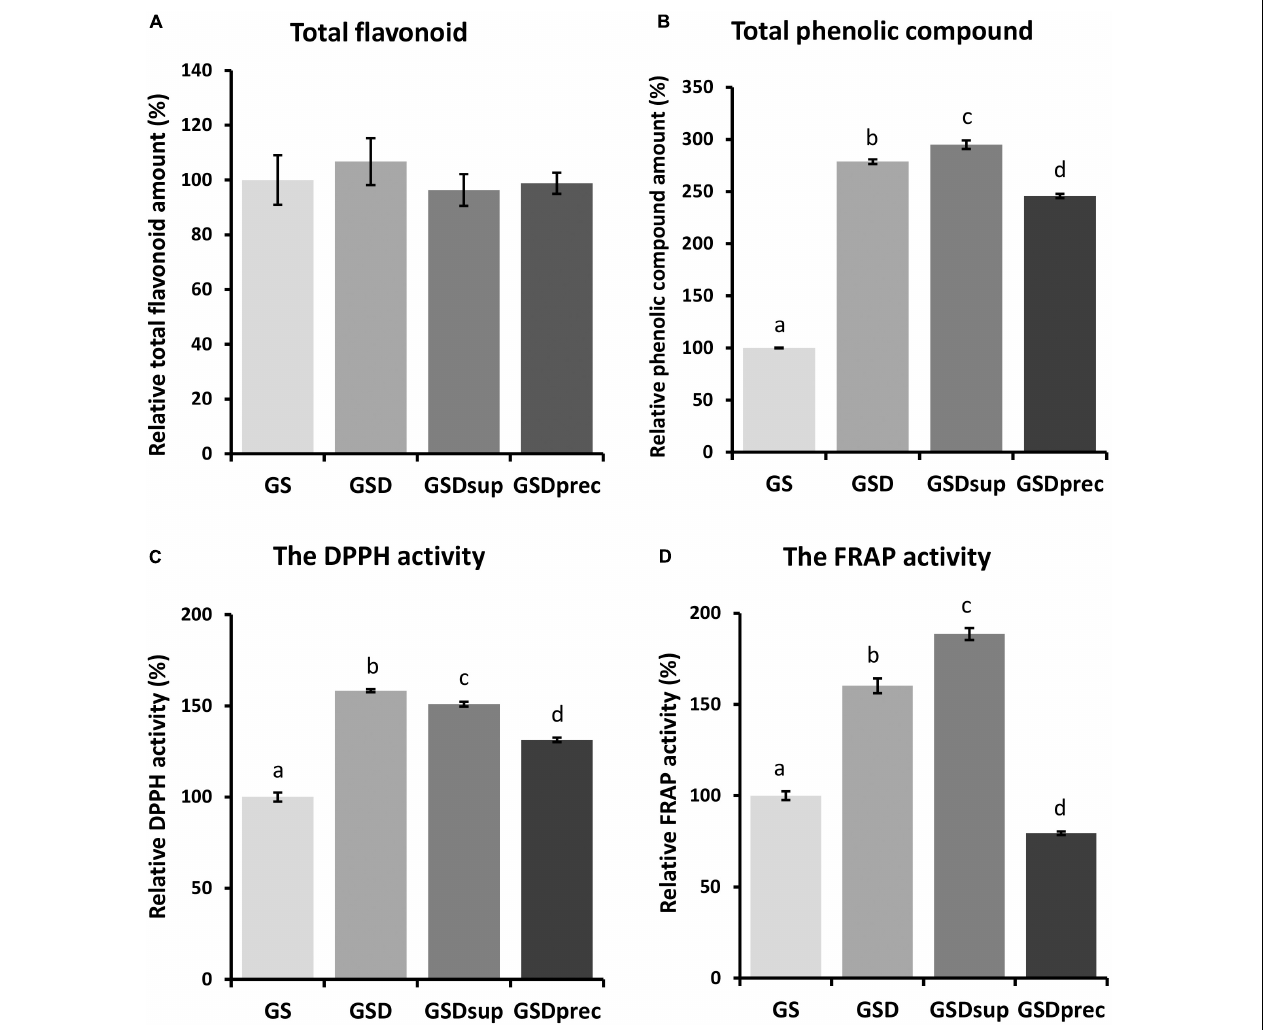
FIGURE 4 | The amounts of phytochemicals and antioxidant activities of 80% methyl alcohol (MeOH) extracts of GS, GSD, GSDsup, and GSDprec. (A) There were non-significant differences in the amounts of total flavonoids among the 80% MeOH extracts of GS, GSD, GSDsup, and GSDprec [ F ( 3 , 19 ) = 0.38698, p = 0.76]. (B) There were significant differences in the amounts of total phenolic compounds among the 80% MeOH extracts of GS, GSD, GSDsup, and GSDprec [ F ( 3 , 19 ) = 1229.14, p = 4.0 × 10 - 19 ]. (C) There were significant differences in the 1,1-di-phenyl-2-picryl-hydrazyl (DPPH) radical scavenger activities among the 80% MeOH extracts of GS, GSD, GSDsup, and GSDprec [ F ( 3 , 19 ) = 261.98, p = 8.3 × 10 - 14 ]. (D) There were significant differences in the ferric-reducing ability of plasma (FRAP) activities among the 80% MeOH extracts of GS, GSD, GSDsup, and GSDprec [ F ( 3 , 19 ) = 304.9, p = 2.5 × 10 - 14 ]. The letters above the error bars represent significant differences as determined by one-way ANOVA and Tukey’s HSD post-hoc